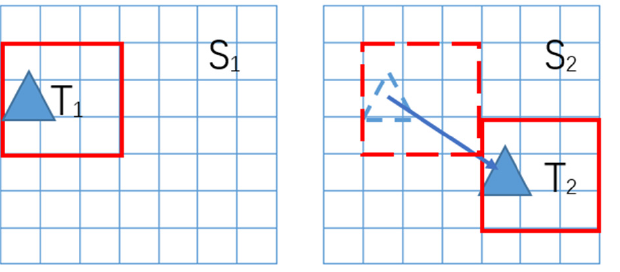
Figure 2. Pattern ‐ matching process. T 1 is the template from the S 1 and T 2 is the matching position of T 1 in S 2 . Select a template T 1 from S 1 , then traverse the S 2 with T 1 , and calculate the correlation coefficients between S 2 and T 1 , T 2 is the position with highest value of coefficient.